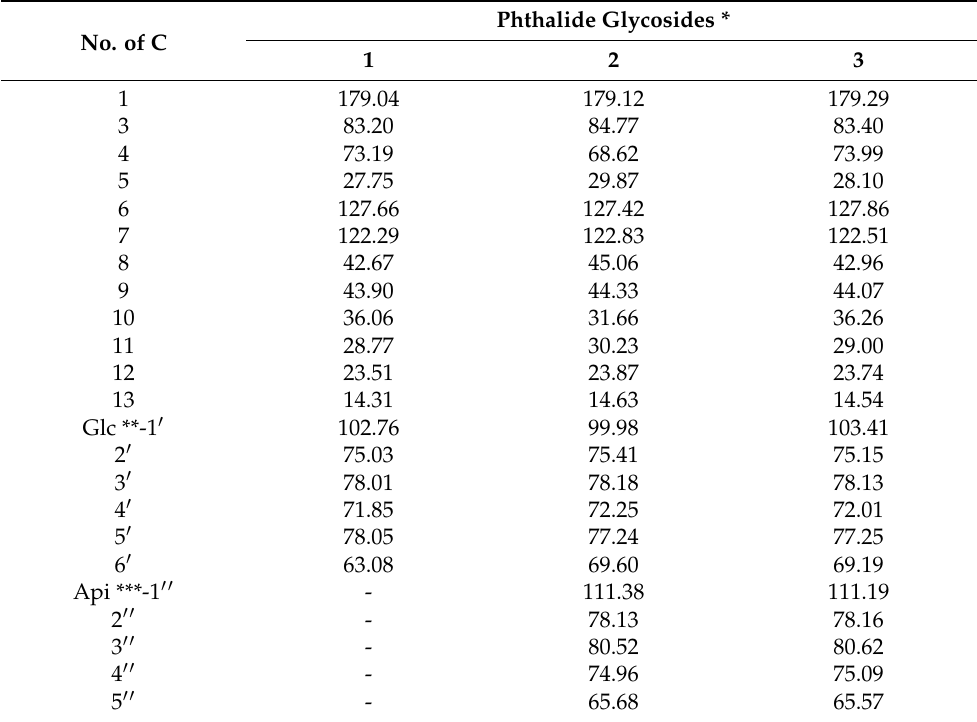
Table 1. 13 C-NMR data on the phthalide glycosides from the rhizome of Cnidium officinale Makino (125 MHz, CD 3 OD, δ C